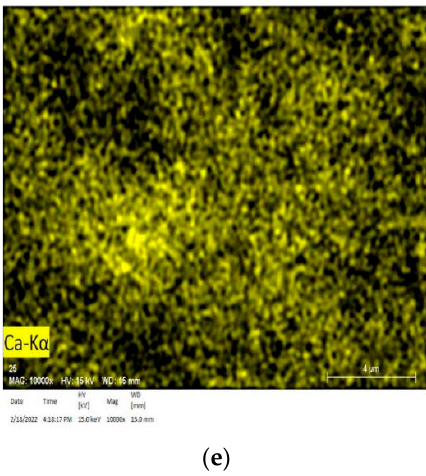
Figure 10. SEM, mapping element analysis. ( a ) SEM image of DH aggregate with 5–10 mm grain cured in TMAH at 80 ◦ C for 105 days. ( b ) mapping analysis determined in Figure 10a. ( c ) O images. ( d ) Mg images. ( e ) Ca